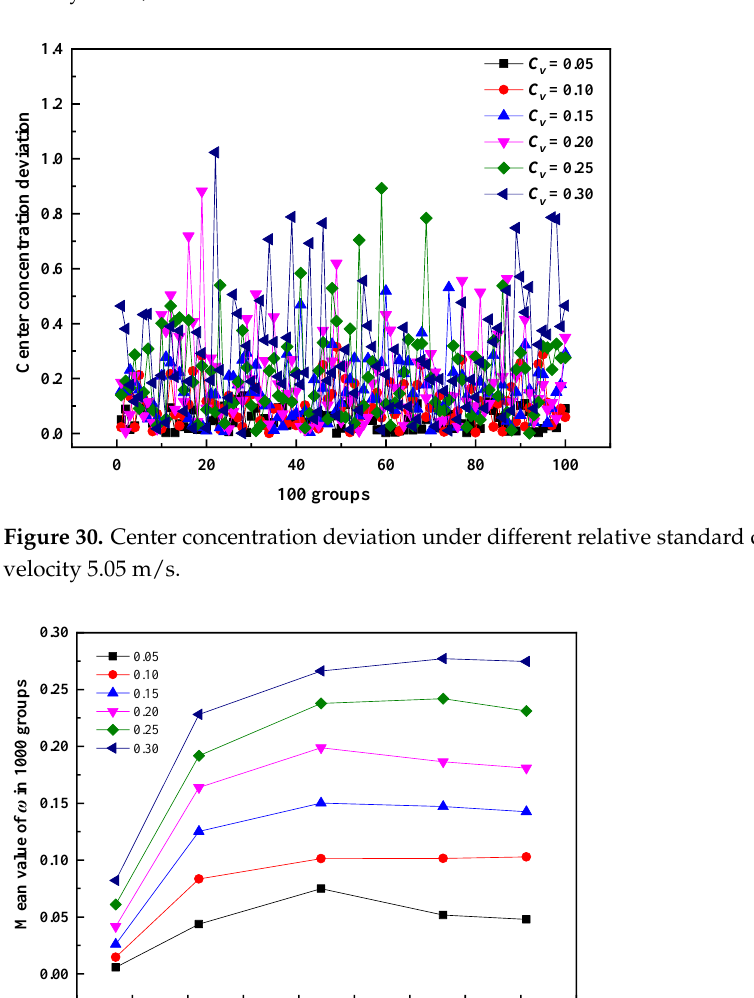
Figure 29. Center concentration deviation under different relative standard deviations of velocity at velocity 4.3 m/s.